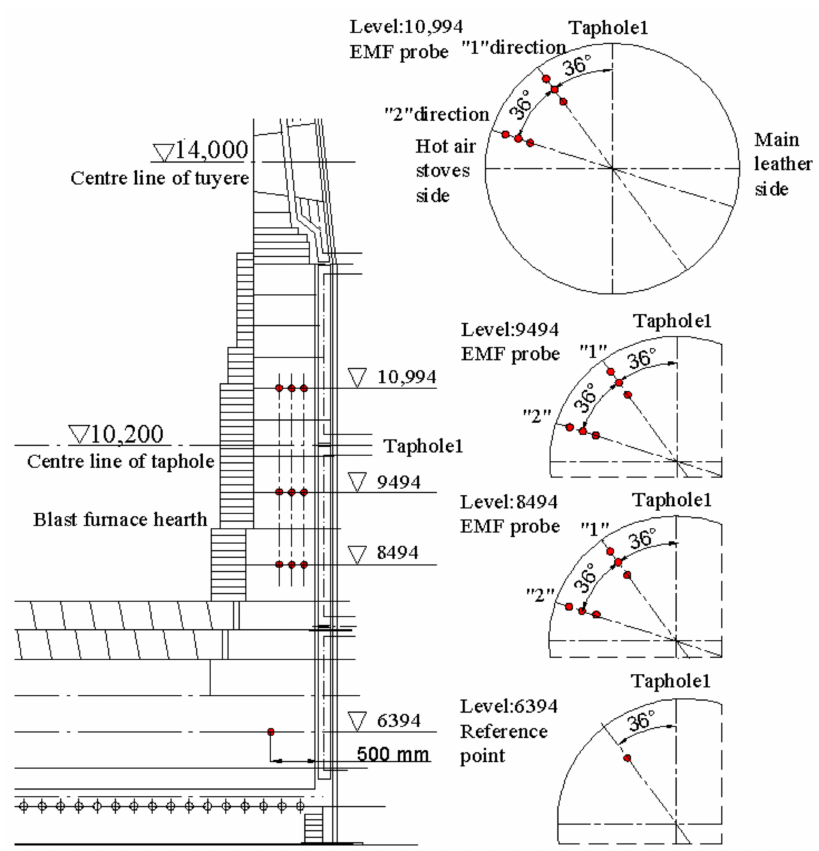
Figure 7. EMF sensors (signals) on the refractory wall of a new blast furnace hearth (left: front view of EMF locations at level 6394, 8494, 9494, and 10,994, right: top view of EMF locations in each